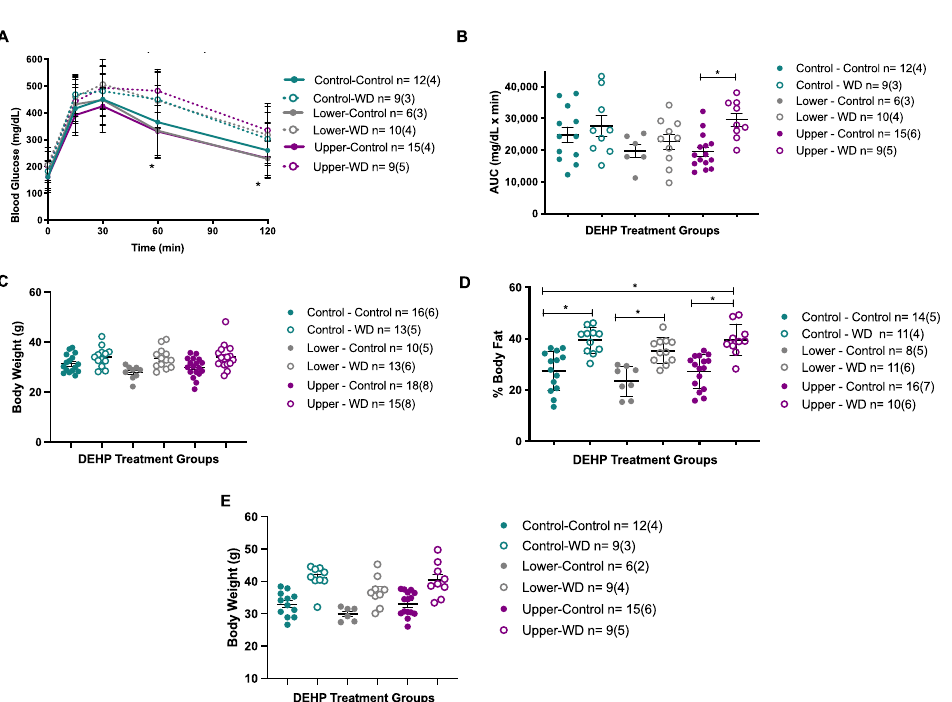
Figure 3. F1 male adult offspring metabolic phenotyping profile. At PND140: ( A ) Glucose tolerance test, ( B ) Glucose Area Under the Curve (AUC, mg/dL × min), and ( C ) Body weight. At PND182: ( D ) Body composition by DEXA scan and ( E ) Body weight. N = # of individuals (# of litters), * p < 0.05.